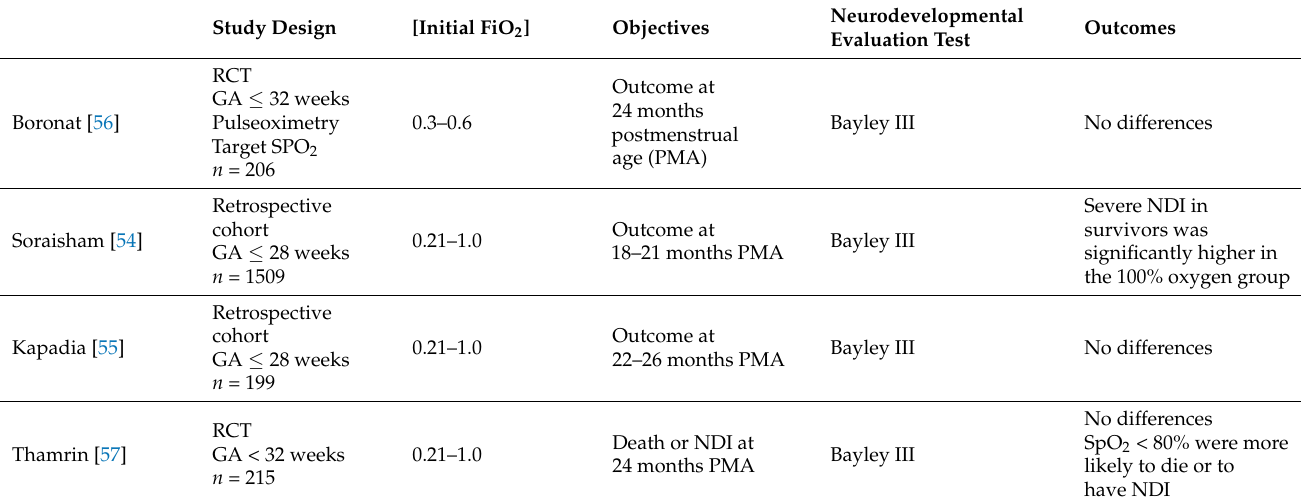
Table 2. Follow-up of clinical studies of preterm infants stabilized with higher vs. lower initial FiO 2 in the delivery